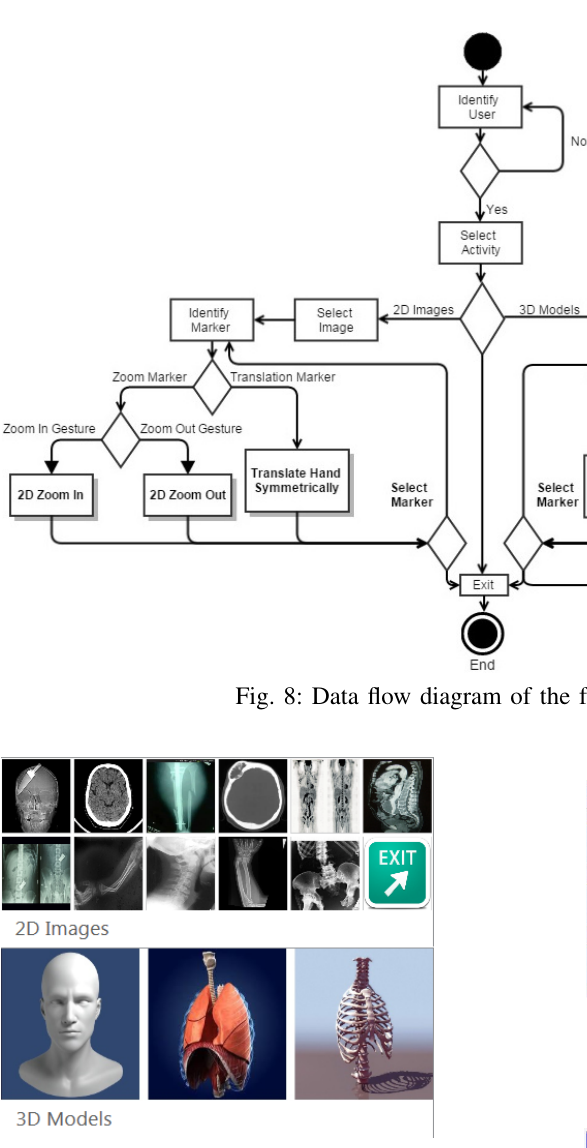
Fig. 9: Menu for selecting the application functionalities.